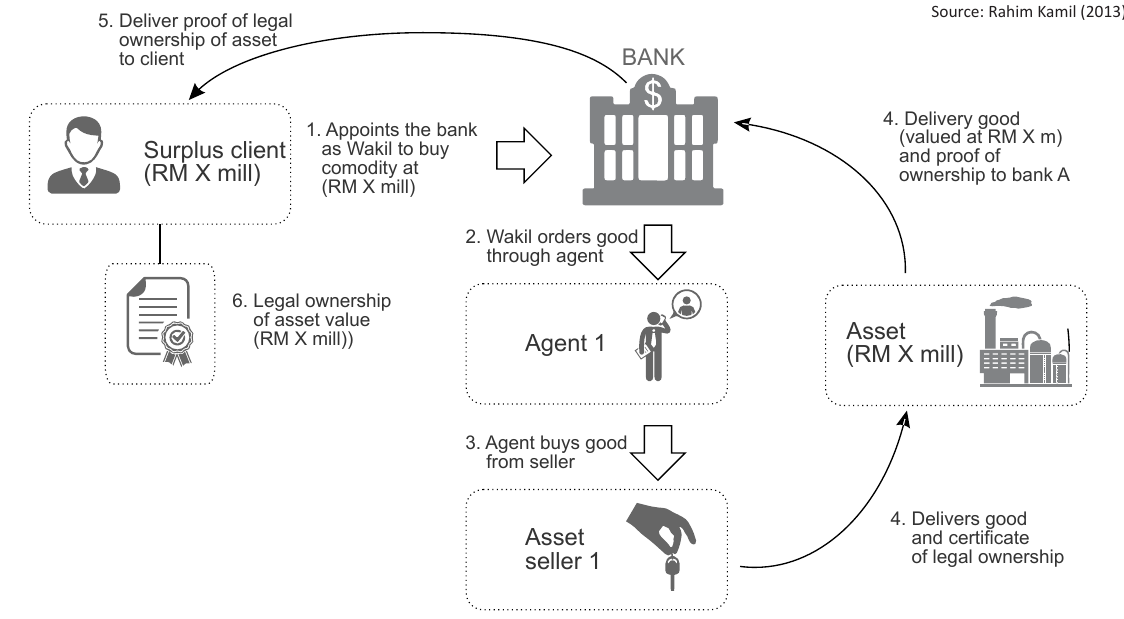
Figure 1. The transactional flow of the first stage of the maintsream tawarruq